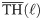
Reduction operation of type T.Depiction of the reduction operation T(N, ℓ). The nodes inside the dotted box form TH¯(ℓ) and will be removed, which will create elementary nodes that will be substituted by arcs.